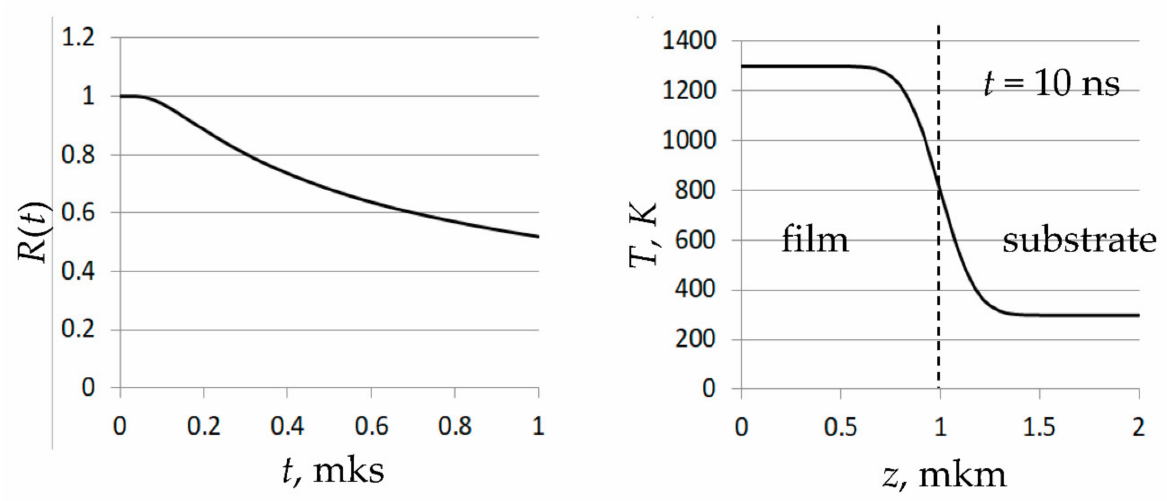
Figure A2. Dependence of R ( t ), Equation (A12), versus time t after the end of film heating, and the dependence of the film temperature T , Equation (A11), along the vertical coordinate z (see Figure 1) at moment t = 10 ns after the end of film